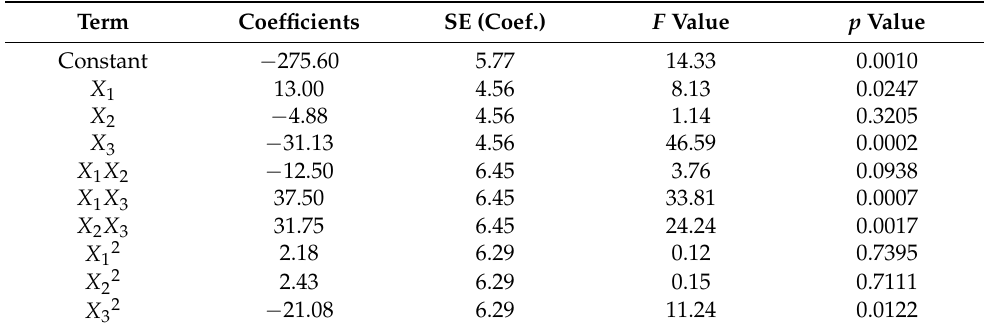
Table 4. Statistical analysis results of BBD data for